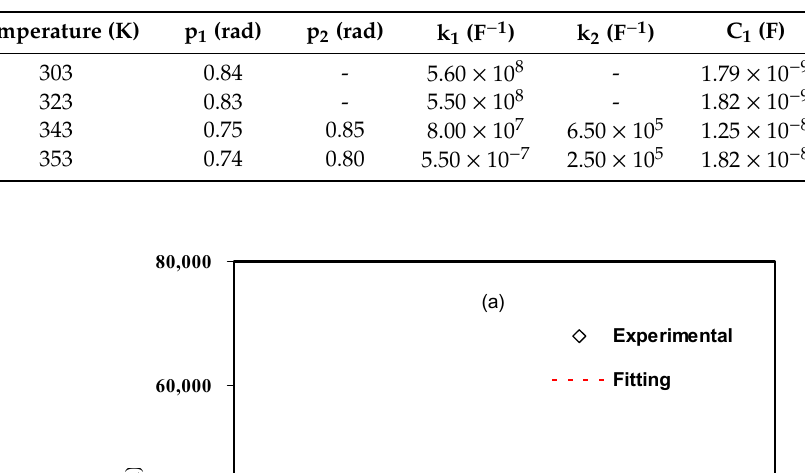
Table 1. The parameters of the circuit elements of the poly (vinyl alcohol) (PVA):LiFC 3 SO 3 solid electrolyte at various